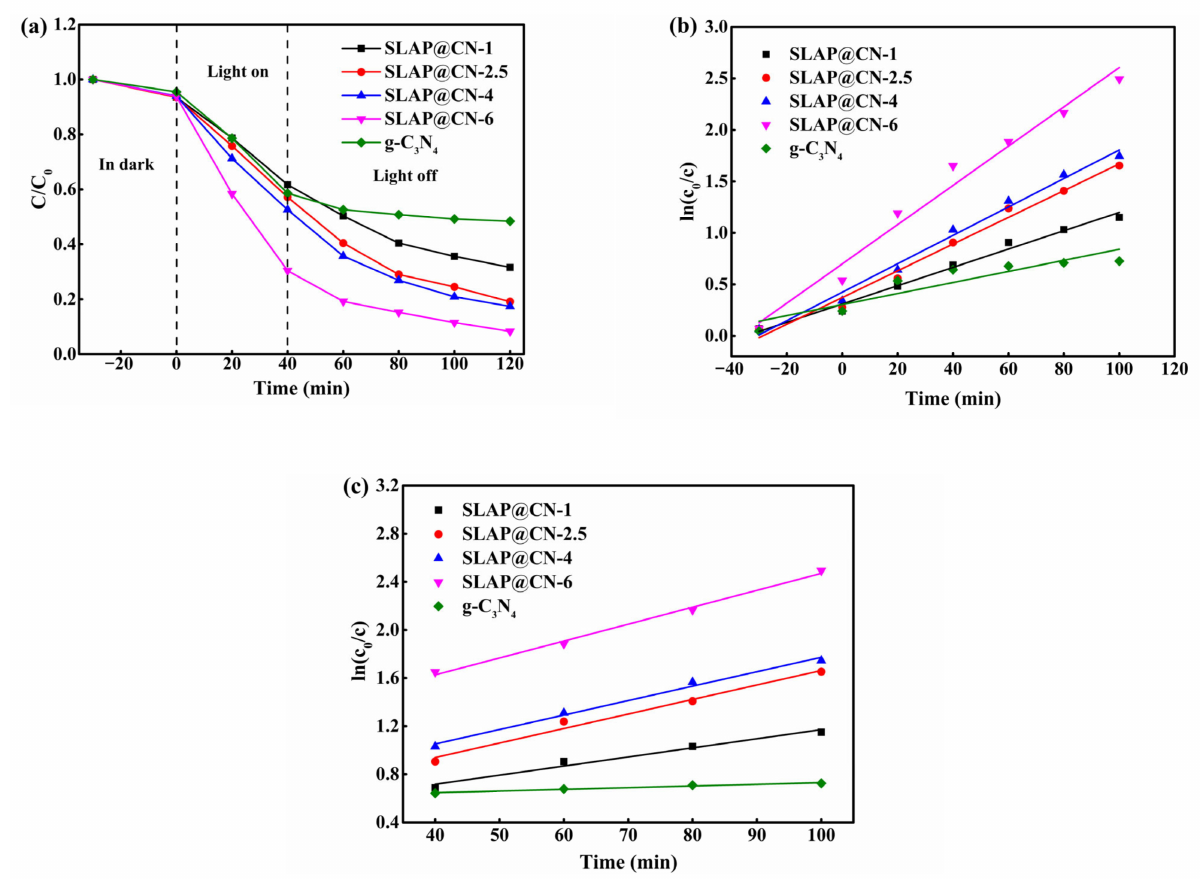
Figure 7. ( a ) Concentration change curves of RhB degradation by g-C 3 N 4 and SLAP@CN under visible light irradiation; ( b ) degradation efficiency of RhB at full stage; ( c ) degradation efficiency of RhB after turning off the light